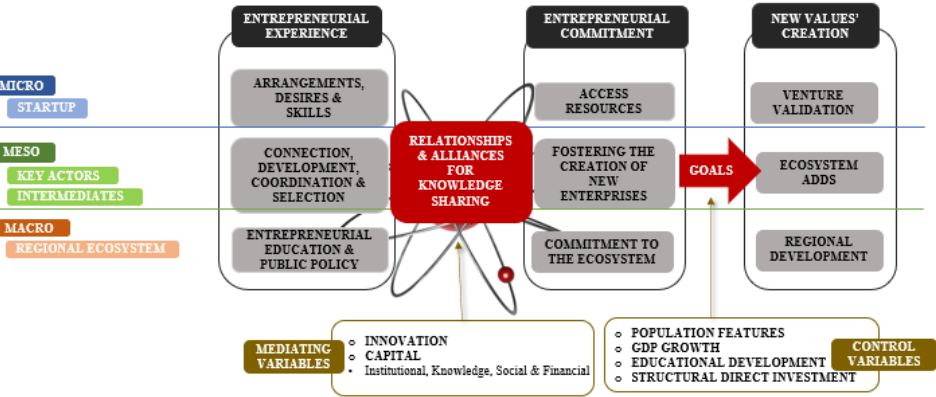
Figure 7. Conceptual model — the knowledge path through entrepreneurial ecosystems.